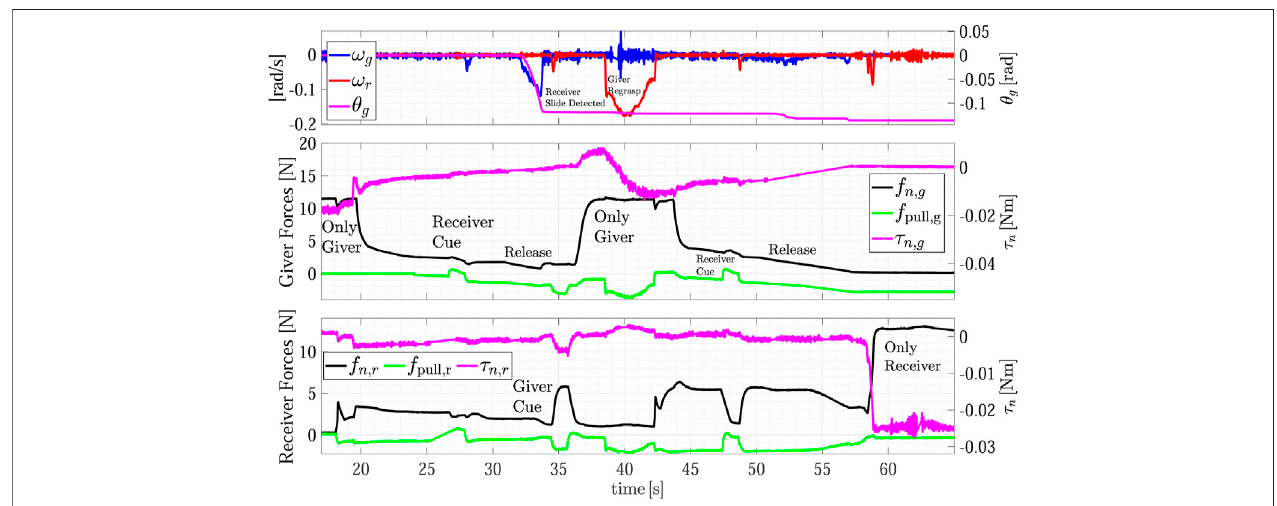
FIGURE14| Fourthexperiment(ObjectC):estimatedslippingvelocitiesofthegiverandthereceiver (top); forcesandtorque measured bythegiver (middle plot); forces and torque measured by the receiver (bottom plot) .